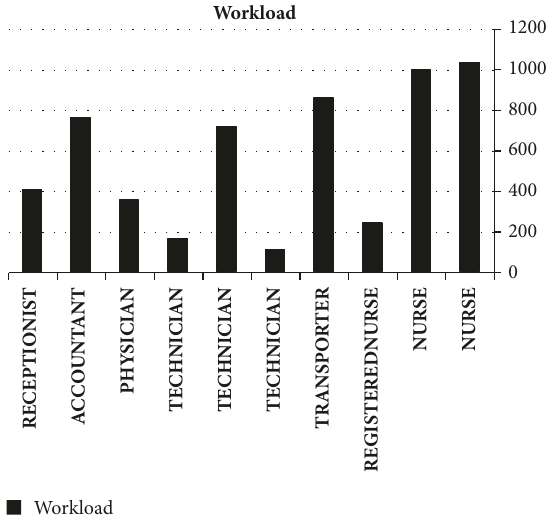
Figure 6: Resources